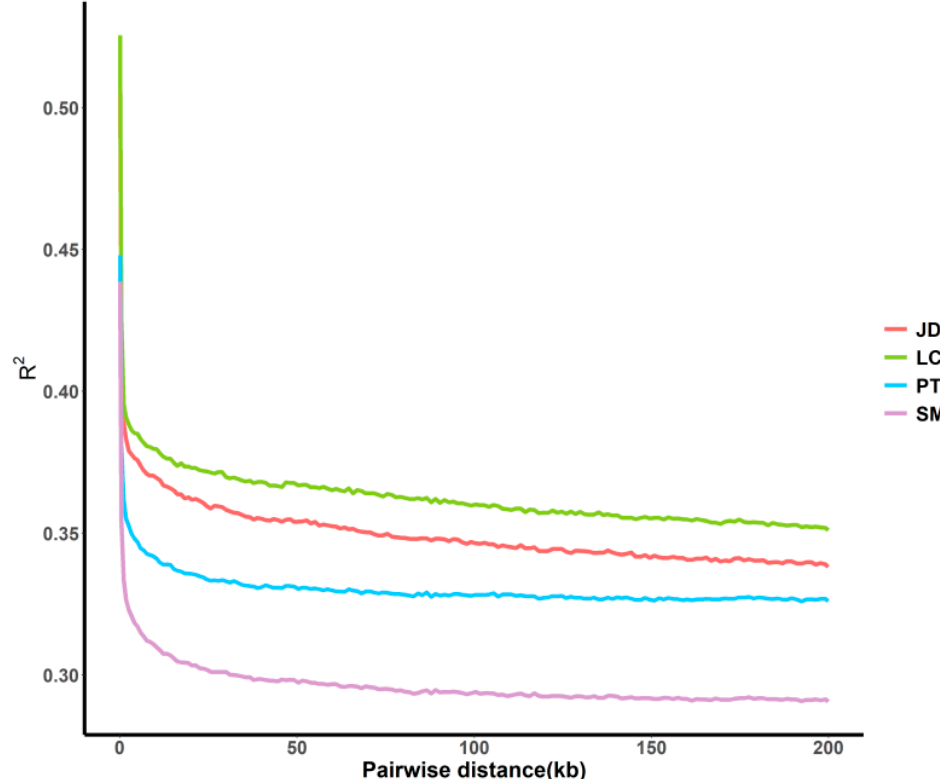
Figure 4. LD attenuation diagrams of duck populations.